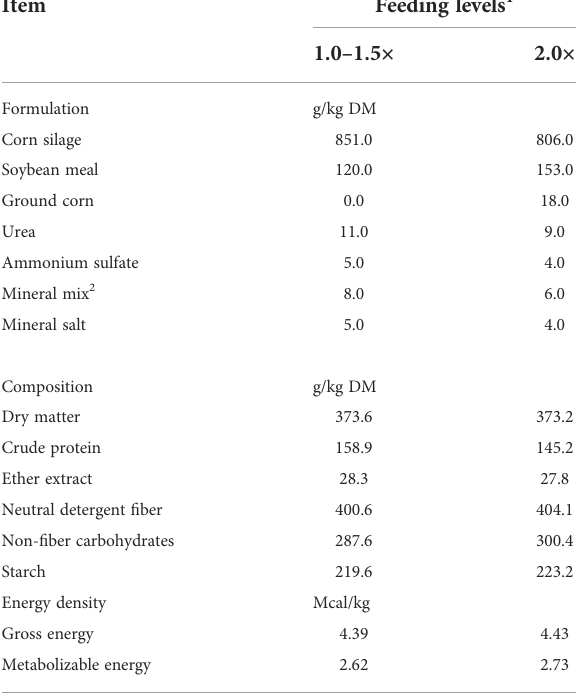
TABLE 1 Ingredients and chemical composition of the experimental